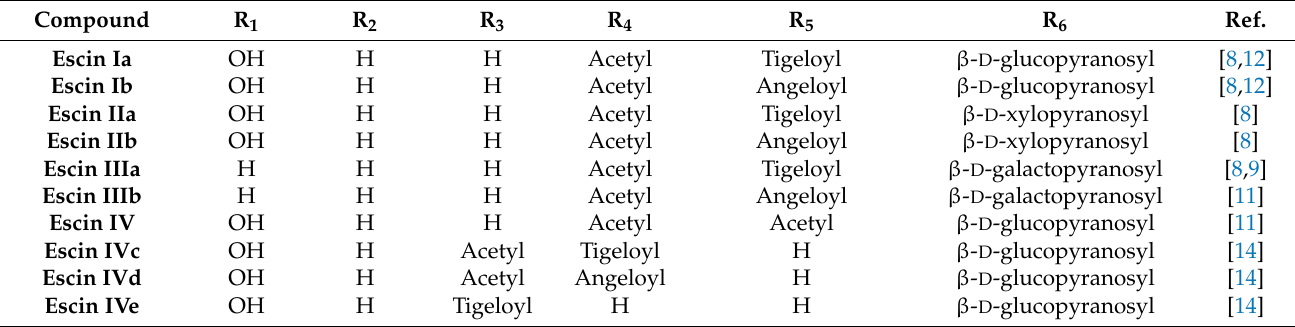
Table 1. Chemical structures of escin. (See also Figure